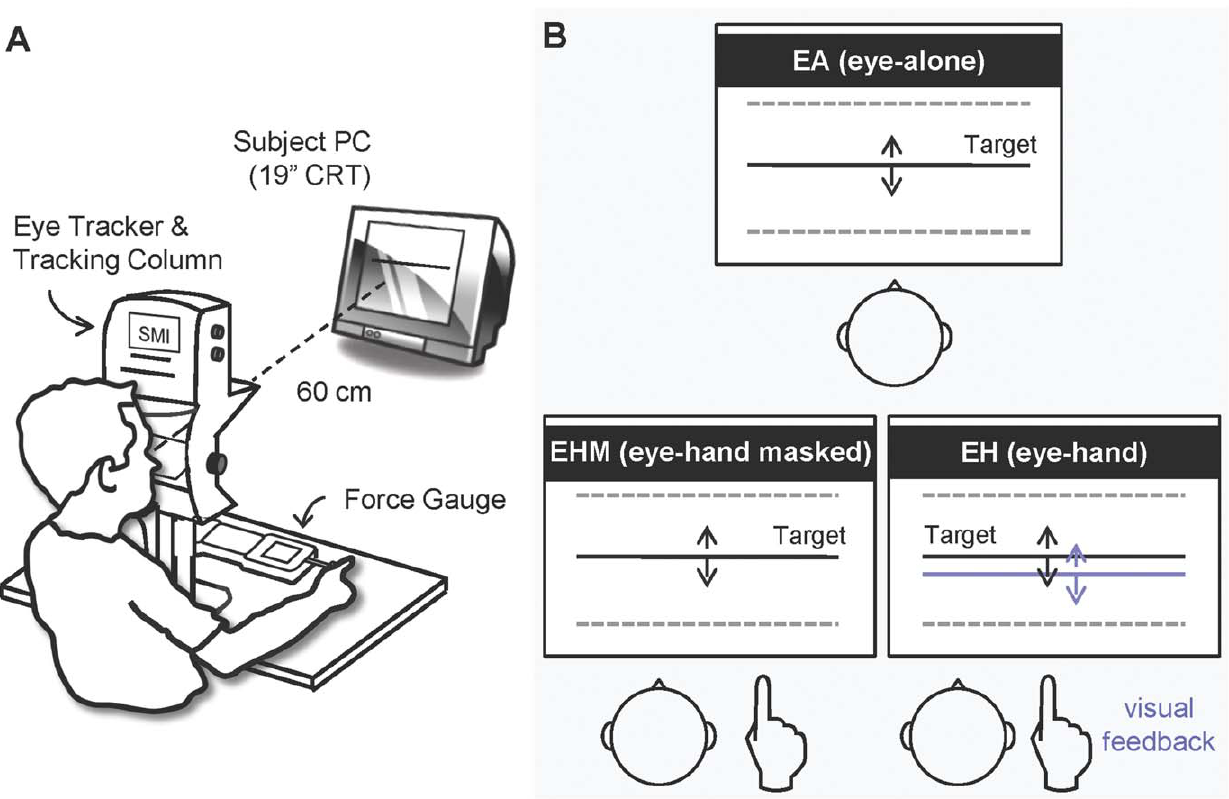
Figure 1. Experimental setup and conditions. (A) A schematic drawing of the experimental setup and the equipment. (B) Diagrammatic representations of the experimental conditions: EA, EHM, and EH tracking. Subjects tracked the target signal (black solid line) visually and/or manually (see the text for details). Timely visual feedback of the manual force output (blue solid line) was available during EH tracking, but was masked during EHM